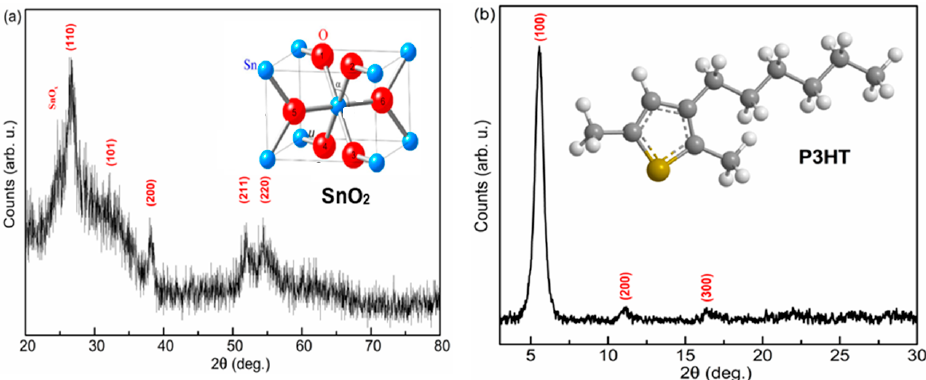
Figure 2. X-ray diffraction patterns of ( a ) sputtered SnO 2 deposited on quartz substrate and ( b ) P3HT spin-coated on glass substrate.